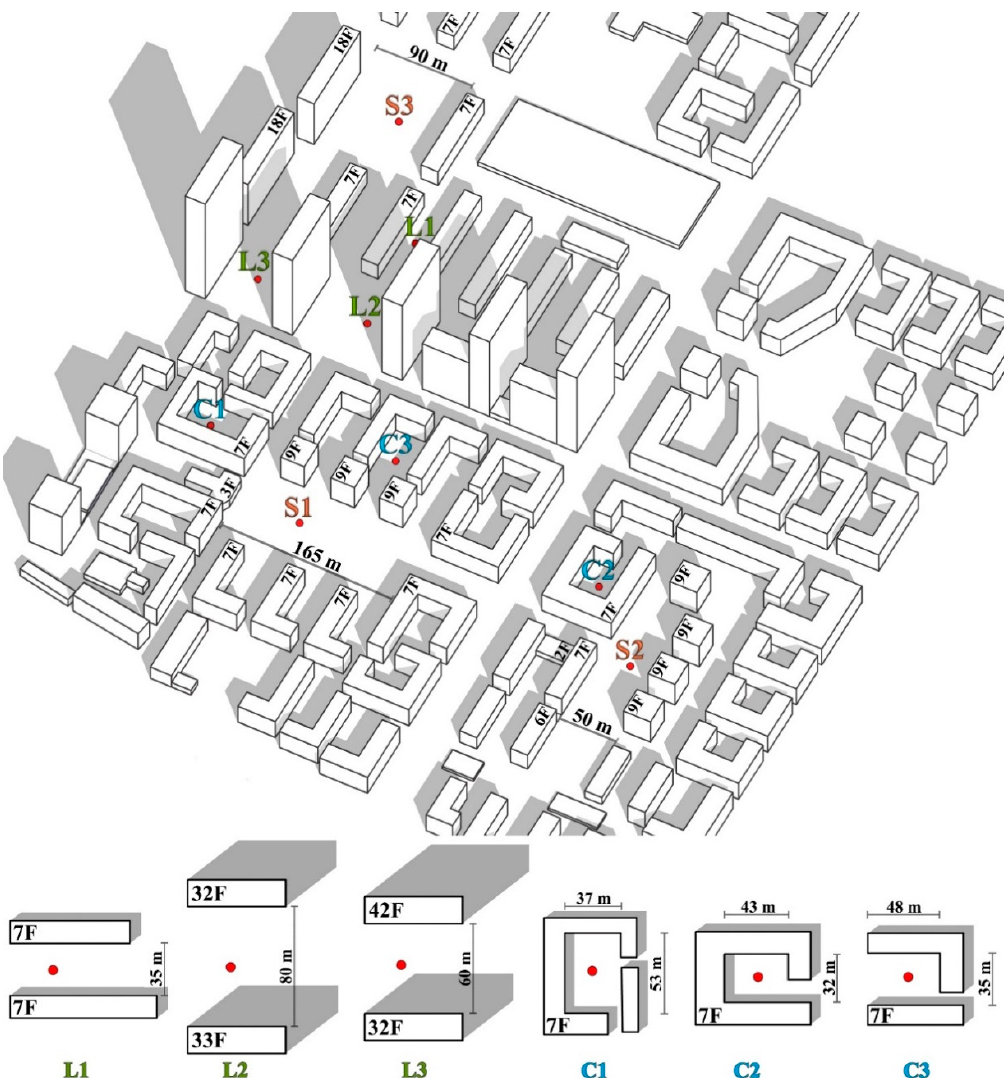
Figure 3. The configurations of the outdoor space at each measurement point.